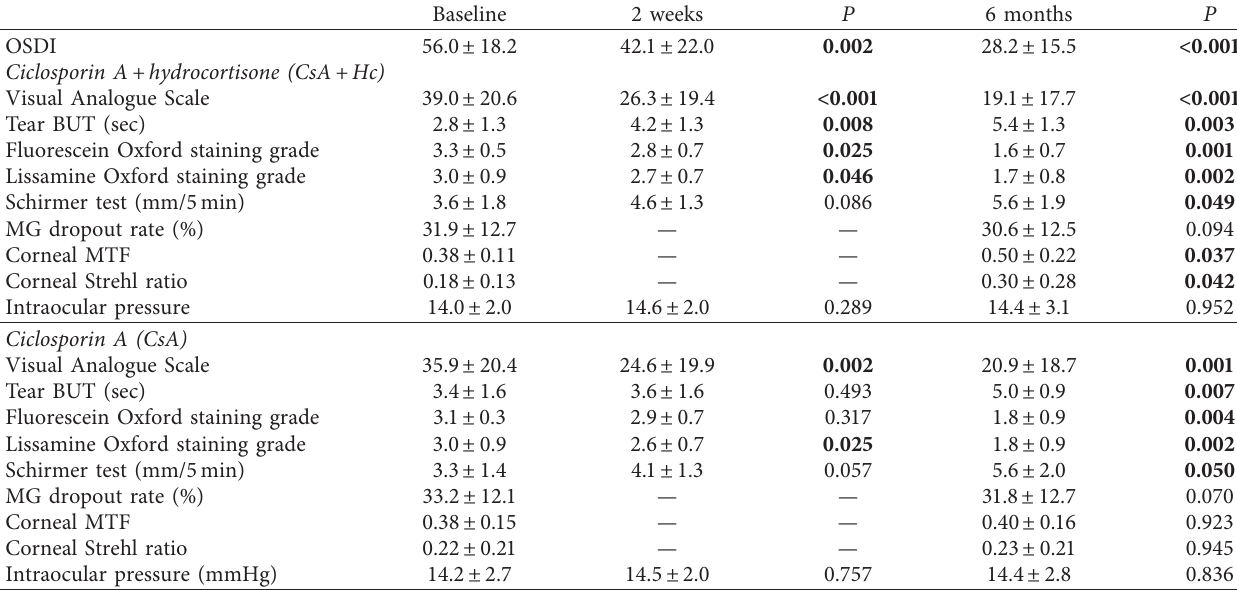
Table 3: Study parameters at baseline and after 2 weeks and 6 months of treatment, separately for the two treatment regimens.